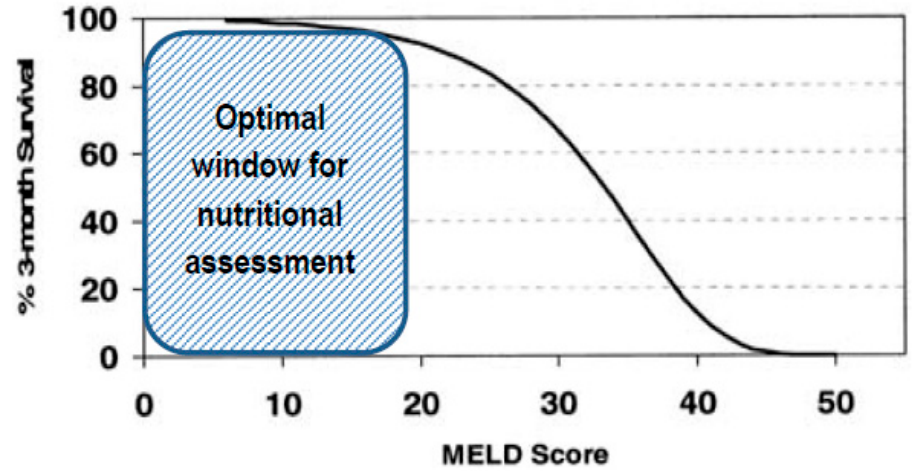
Figure 2. Optimal window for nutritional assessment according to Model for End-Stage Liver Disease (MELD) score and corresponding survival, adapted from Wiesner et al. [115].